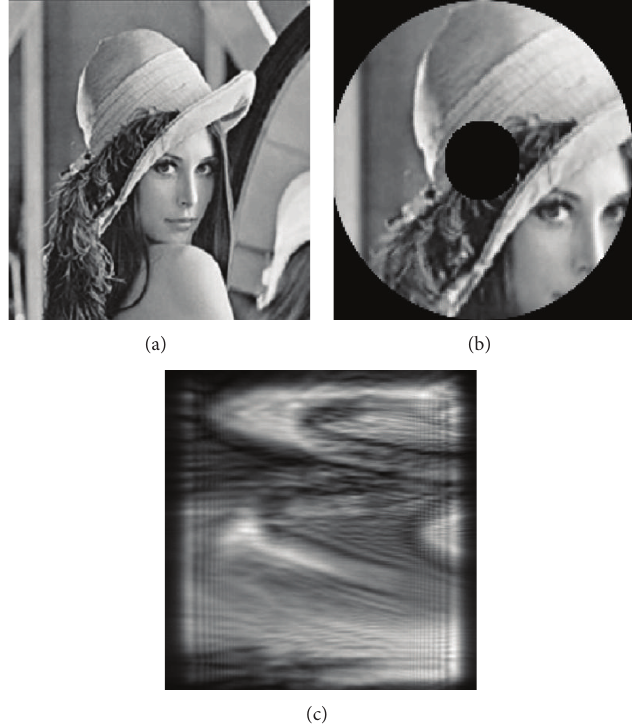
Figure 3: (a) Arbitrary Input grayscale image Lena with 256 × 256 pixels. (b) Annular domain image with center position (𝑐 𝑥 , 𝑐 𝑦 ) = (96, 108) , = 20, 𝑟 = 80 [30]. (c) The fractional Mellin transformed amplitude image of order 0.3 in both directions. and the inner and outer radii are 𝑟 in out